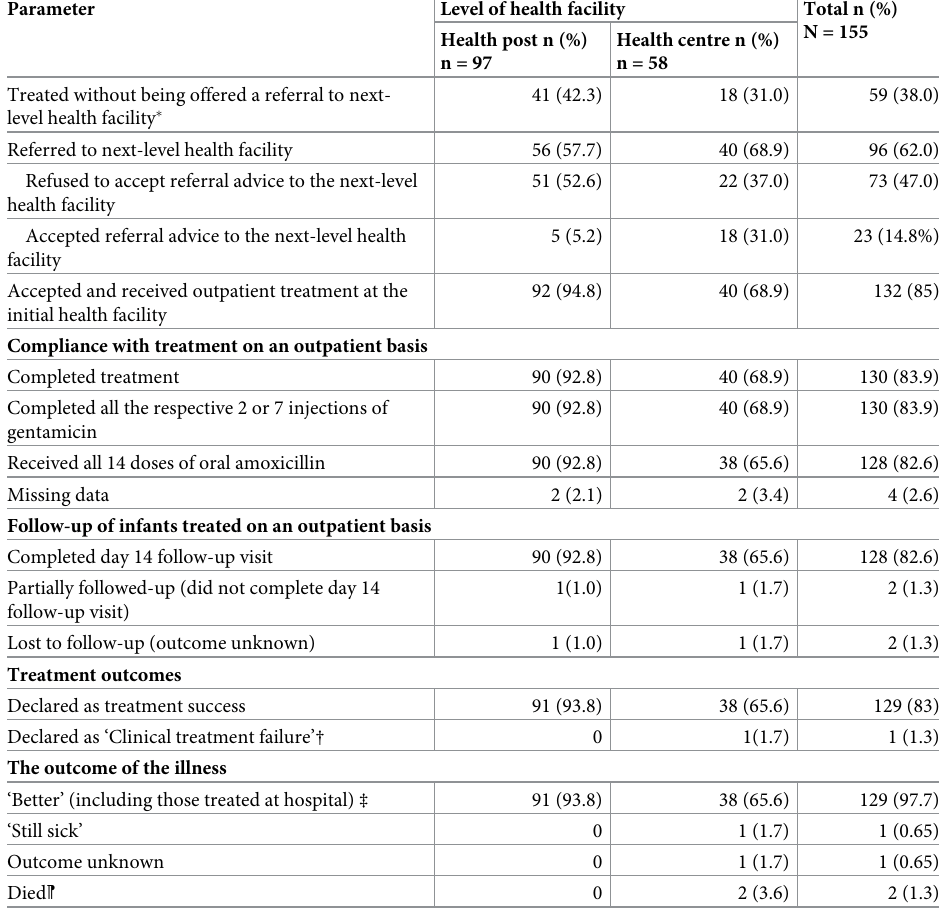
Table 2. Identification and outcomes of infants 0–59 days old with signs of clinical severe infection presenting at health centres and health posts.